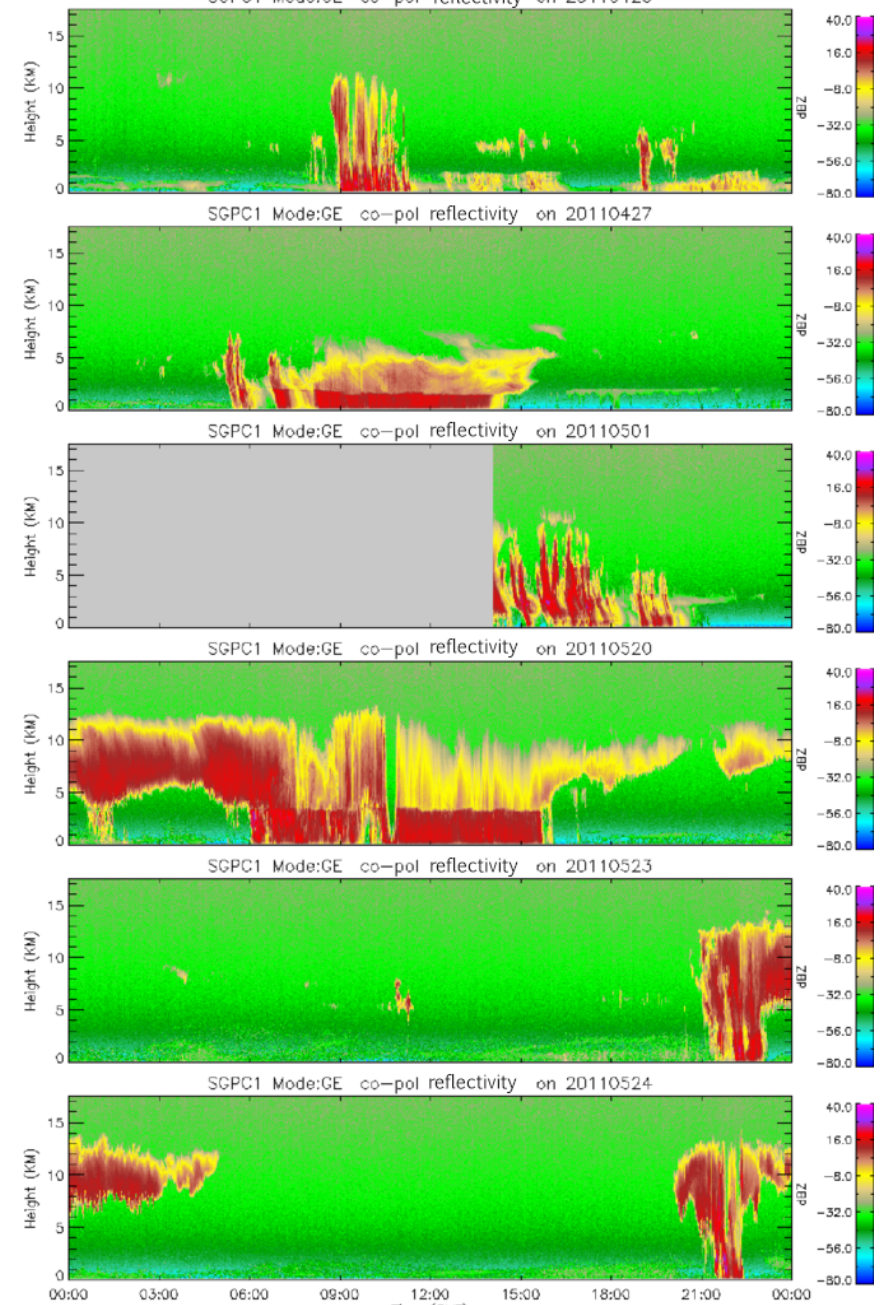
Figure 2. KAZR radar reflectivity at the central facility during six case studies that began on 25 and 27 April, and 1, 20, 23, and 24 May 2011.